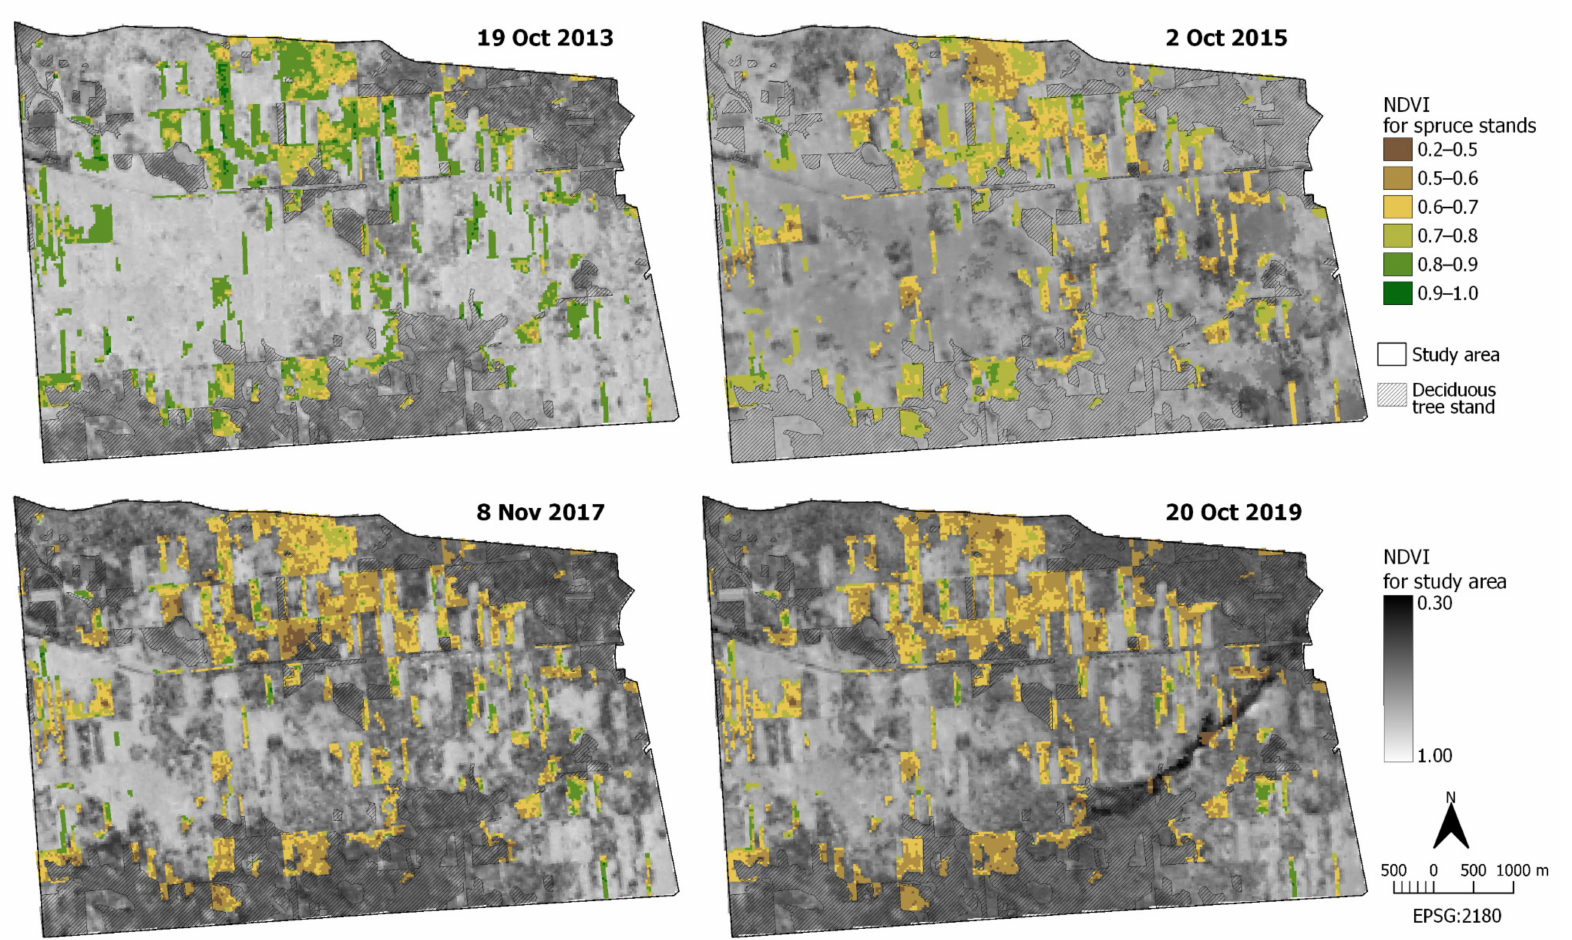
Figure 4. Spatial NDVI distributions for the study area in 2013, 2015, 2017, and 2019. Landsat Surface Reflectance products courtesy of the U.S. Geological